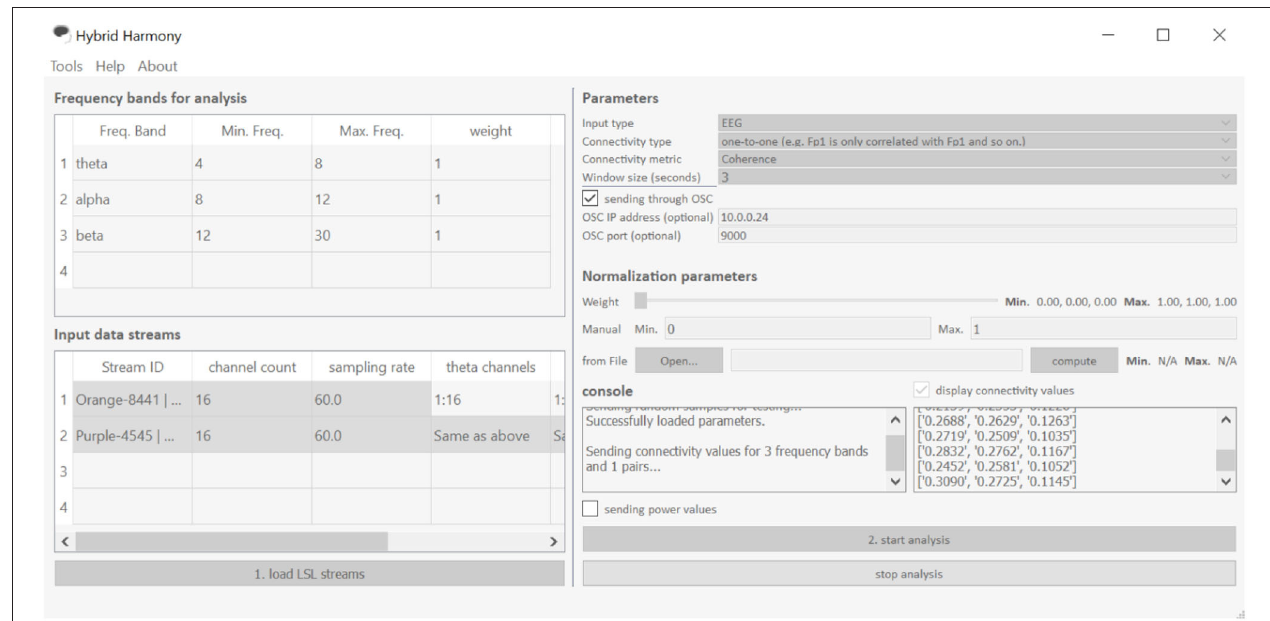
FIGURE 3 | The Hybrid Harmony GUI. The interface is divided into five sections: “Frequency bands for analysis,” “Input data streams,” “Parameters,” “Normalization parameters” and “Console,” the first four of which allow users to specify the parameters detailed in section Data Preprocessing, Connectivity Analysis, Normalization. The GUI facilitates three main actions shown as buttons “load LSL streams,” “start analysis,” and “stop analysis.” “Load LSL streams” will start the stream discovery ( Supplementary Material , Stream Discovery Through LSL) in the backend; “start analysis” button initiates the analyses (section Connectivity Analysis and Normalization) and data transferring ( Supplementary Material , Using LSL for Output). “Stop analysis” will pause the analyses and allow the parameters to be